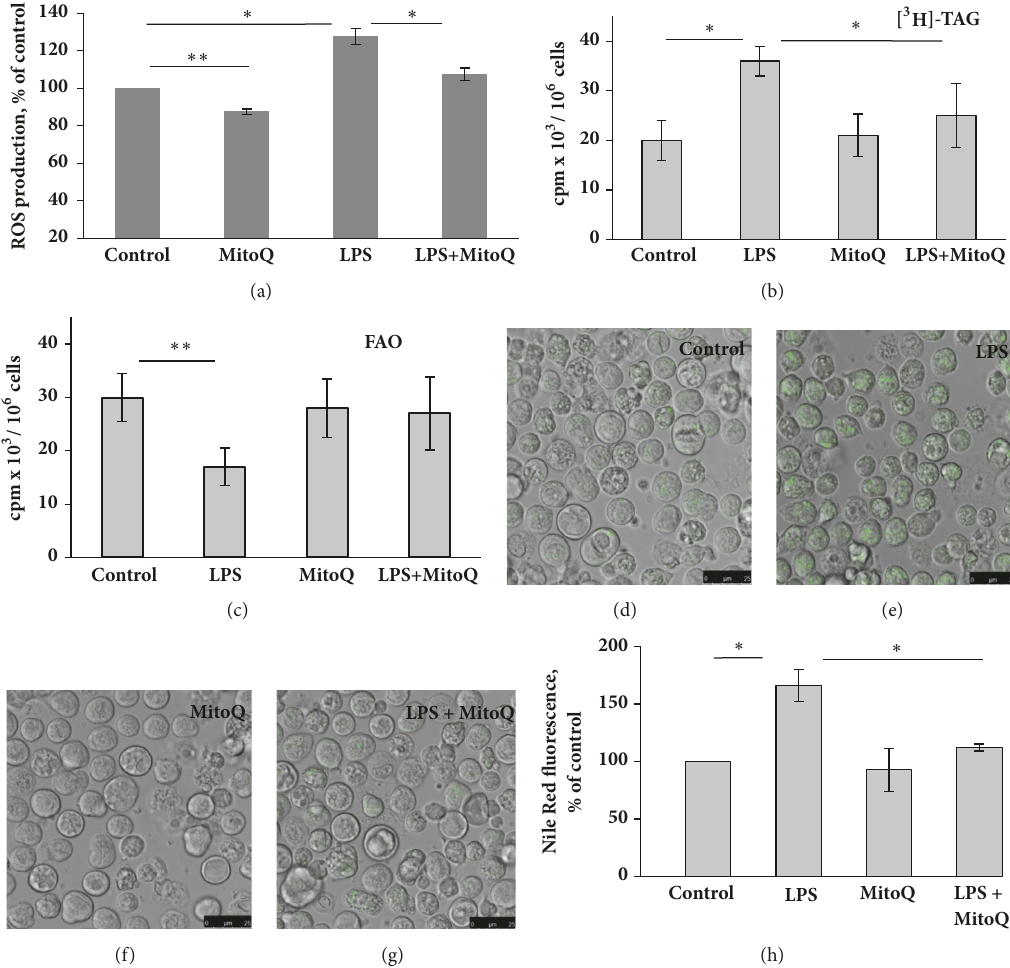
Figure 6: MitoQ decreases basal and LPS-stimulated ROS production (a) and prevented LPS-induced TAG accumulation (b) , decline of FAO (c), and LD biogenesis (d-h) . (a) C ells were pretreated with MitoQ for 2 h and then exposed to 25 𝜇 g/ml LPS for 1 h. The fluorescent dye, DCF-DA, was added to the incubation medium at a final concentration of 10 𝜇 M, 20 min before the end of incubation with LPS, n = 6. (( b)-(h)) Cells were pretreated for 2 h with MitoQ (25 nM) and then incubated for 21 h with 25 𝜇 g/ml LPS. (( b), (c)) Cells were preloaded with [ 3 H]- b 18:1 during 1 h, n=6 independent experiments; (( d)-(h)) Cells were stained with Nile Red, n=4 independent experiments. ∗ p < 0.05; ∗∗ p <